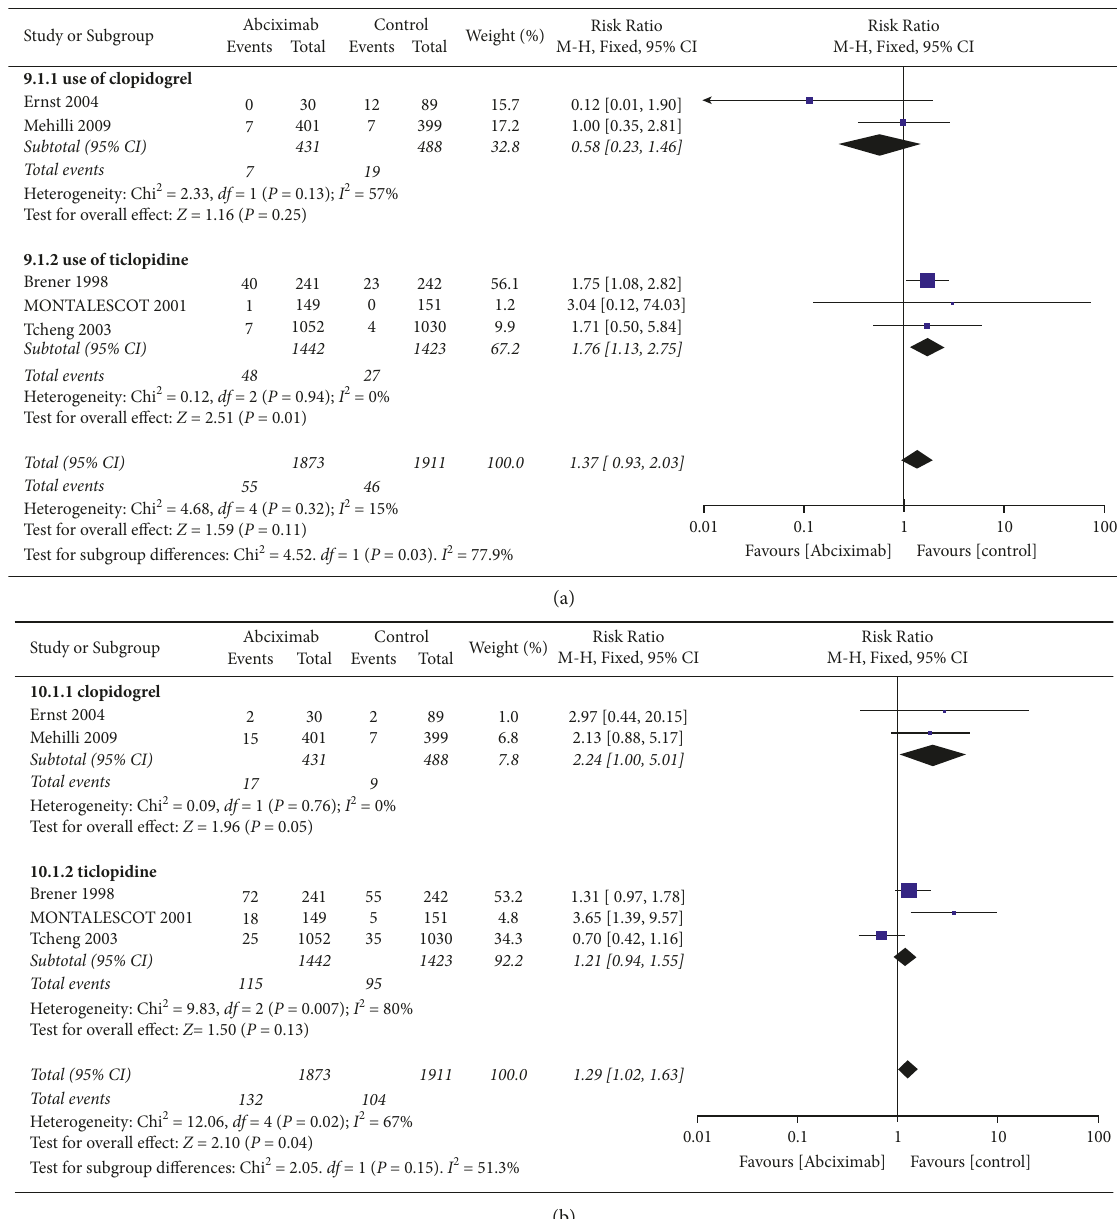
Figure 4: Subgroup analyses in (a) major bleeding and (b) minor bleeding between clopidogrel and ticlopidine